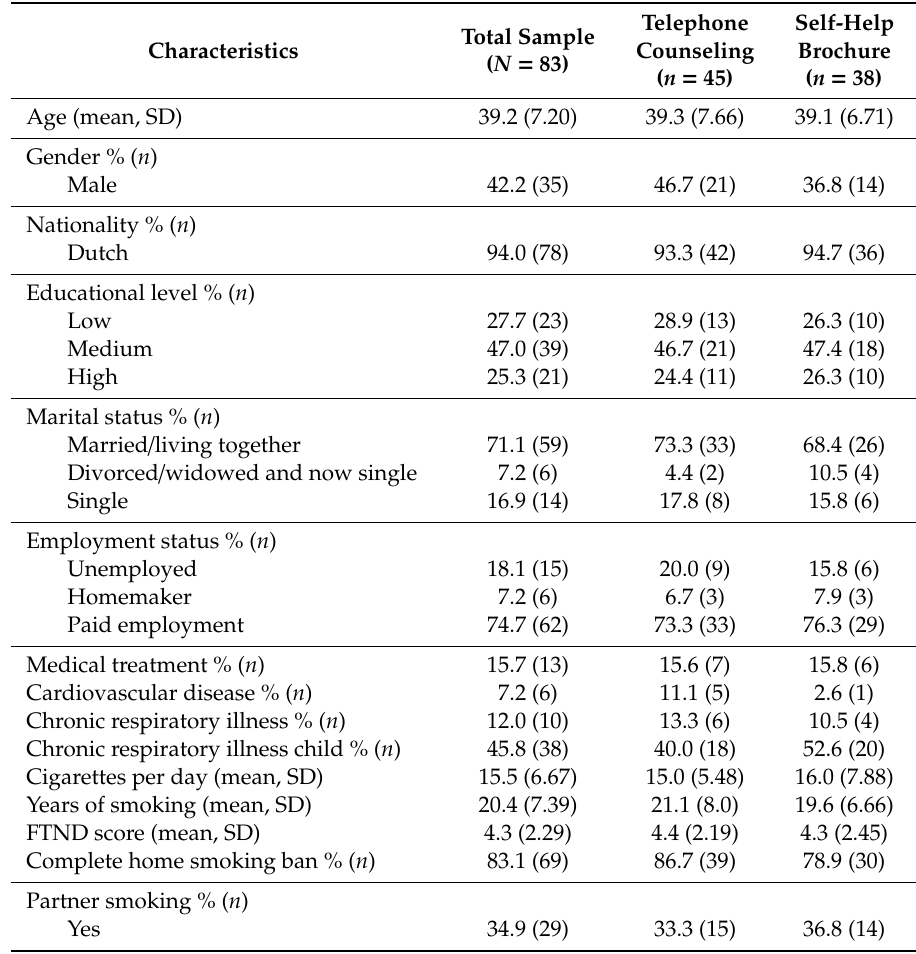
Table 1. Key characteristics of parents at